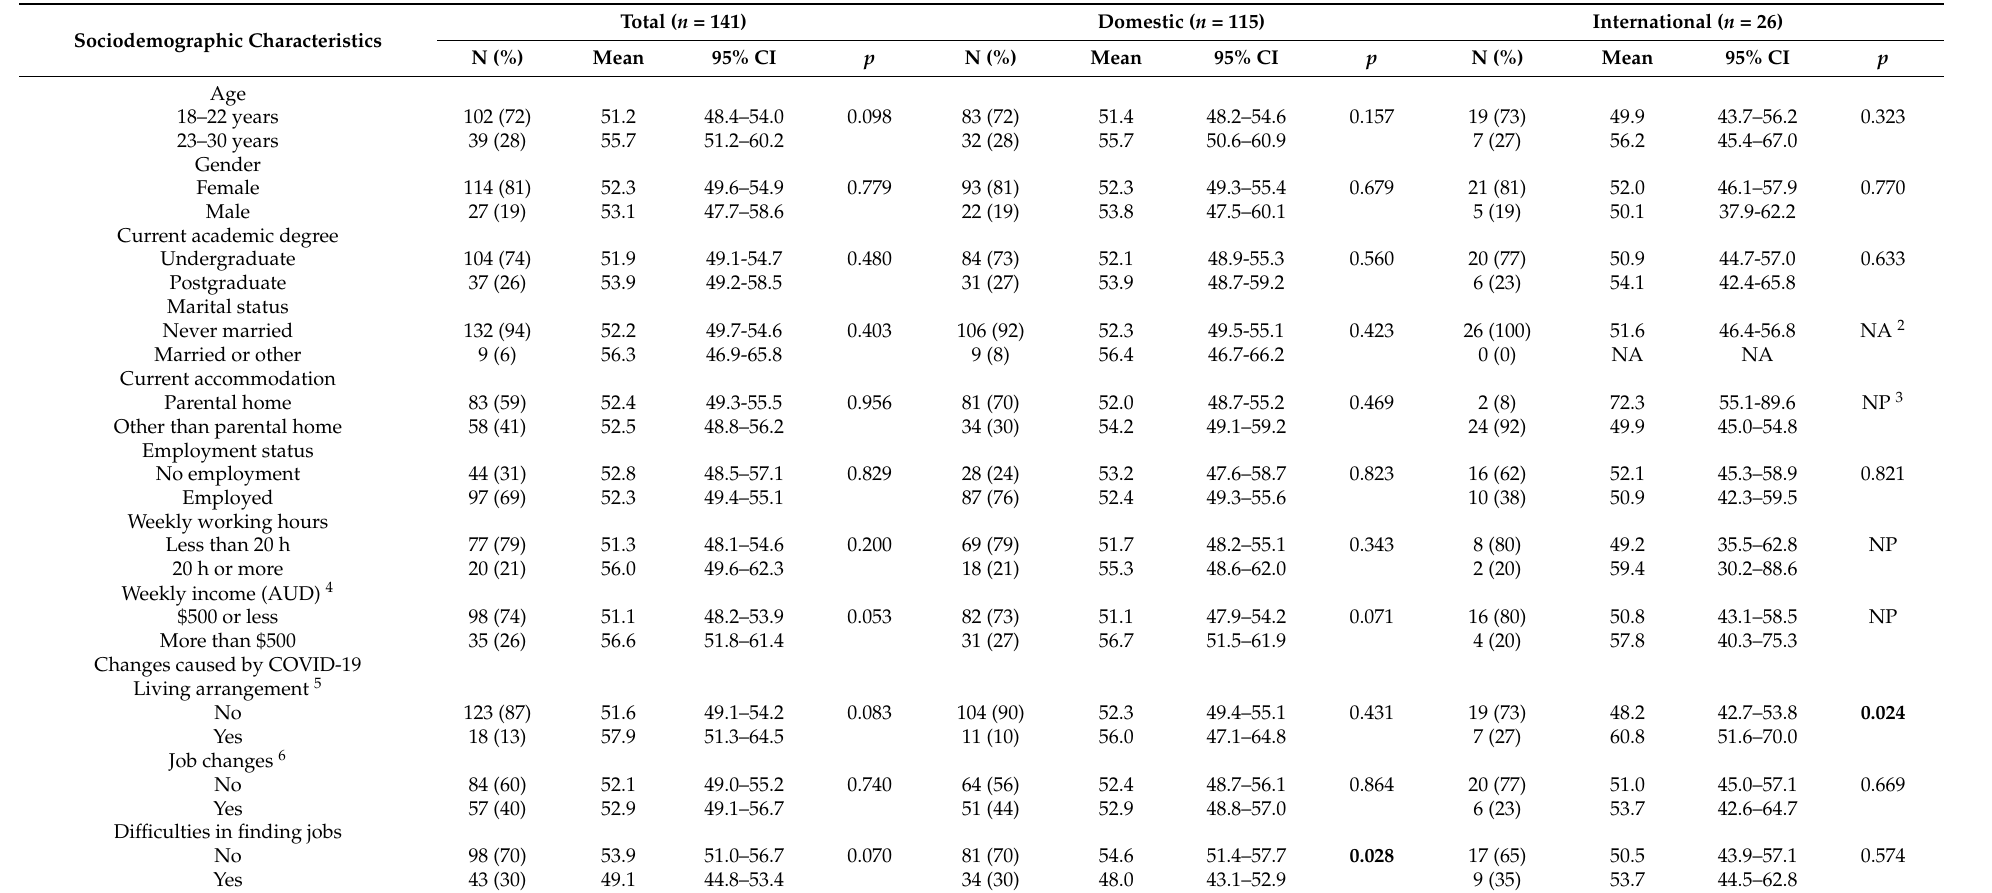
Table 2. Mean scores of Healthy Eating Index for Australian Adults (HEIFA-2013) by sociodemographic characteristics from domestic and international students attending a large Australian university 1